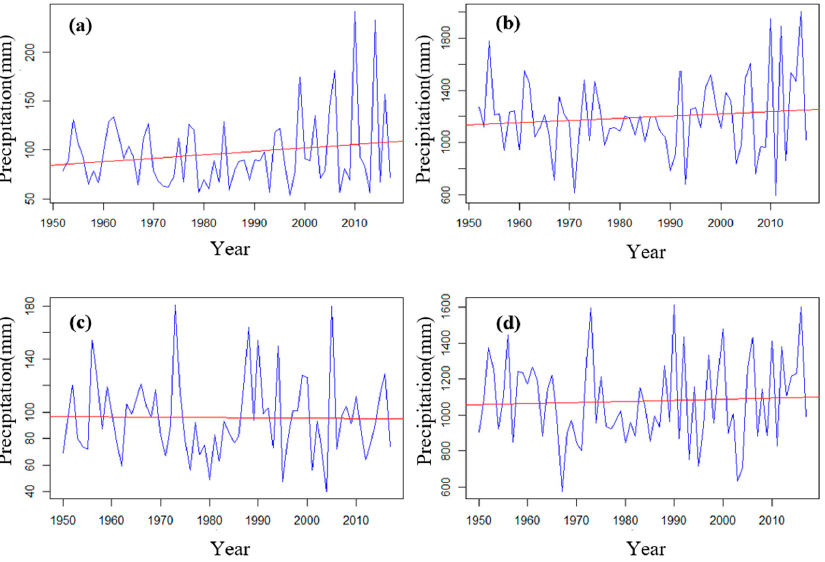
Figure 13. The correlation between annual areal precipitation and annual runoff at Zhuqi in the period before and after 1993.